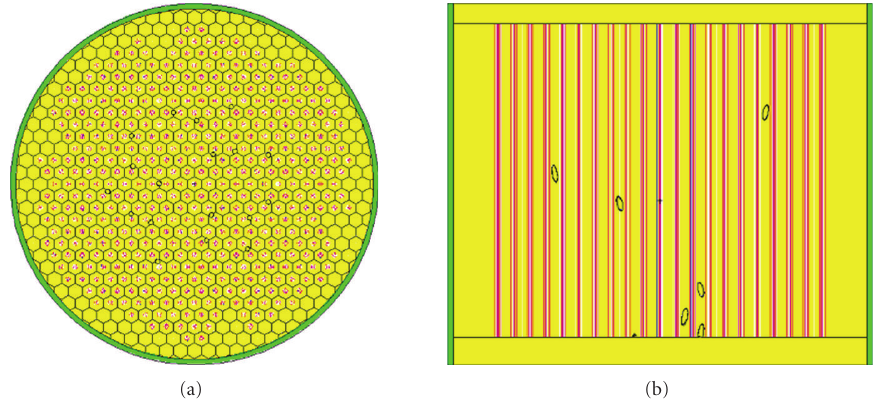
Figure 3: Atucha-2 MCNP5 3D model, planar and axial view.